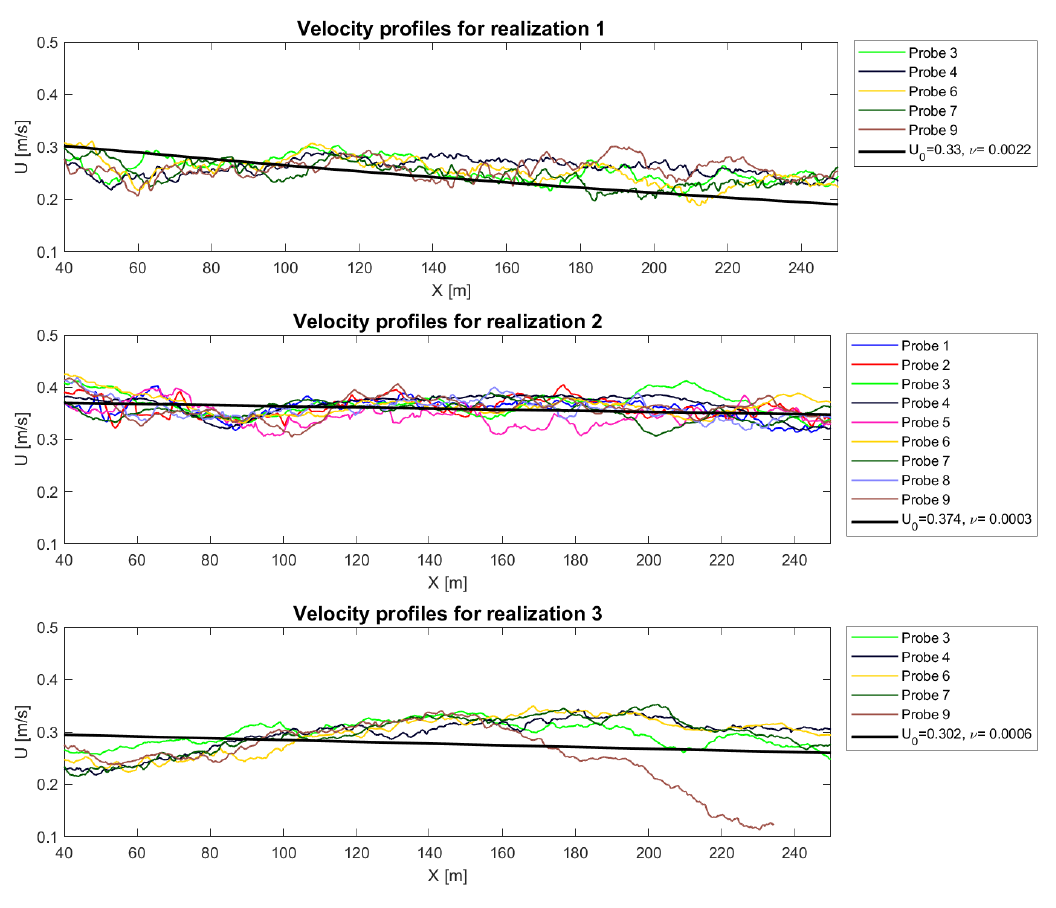
Figure 19. Velocity model